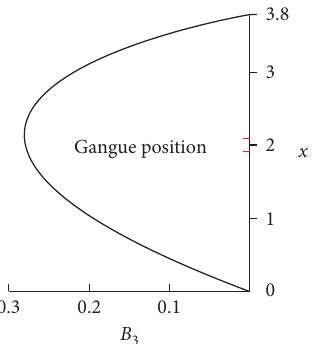
Figure 10: Relationship curve between (B) coal seam